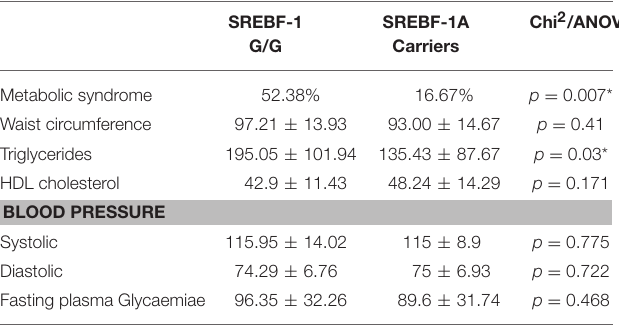
TABLE 5 | Mean and standard deviation of metabolic indices in patients stratified by SREBF-1 genotype.